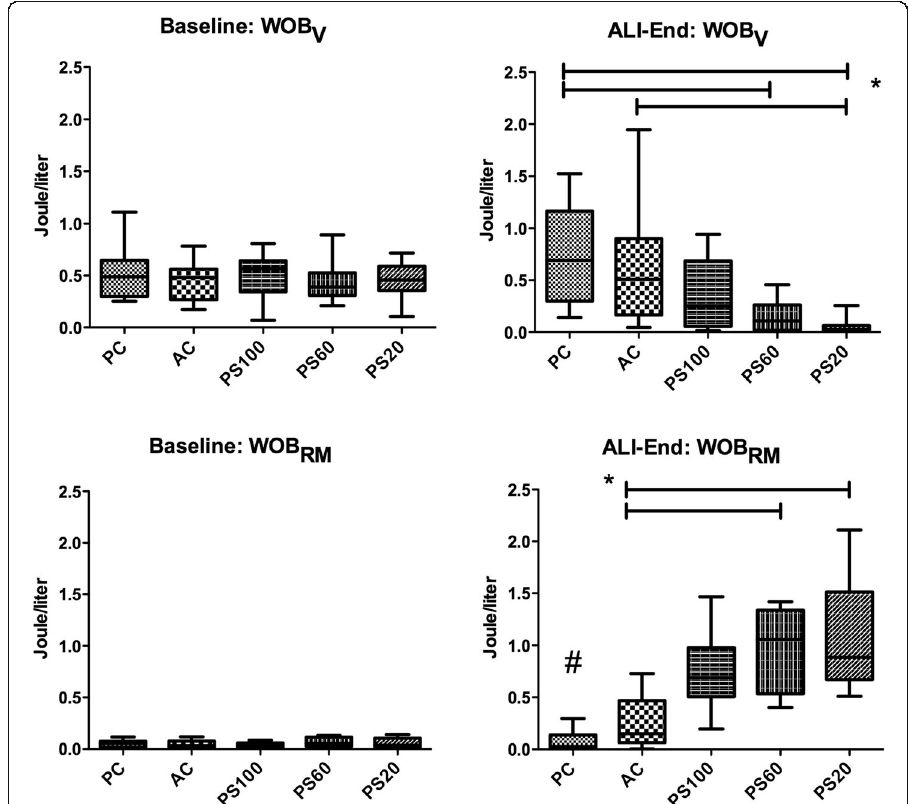
Fig. 1 Work of breathing exerted by the animal (WOB RM ) at baseline and after 4 h (ALI-End) of ventilation with pressure control (PC), assist control (AC), or pressure support ventilation with 100%(PS100), 60%(PS60), or 20%(PS20) of previous pressure control level after establishment of ALI.* p < 0.05 vs. indicator line; # p < 0.05 vs. all other groups